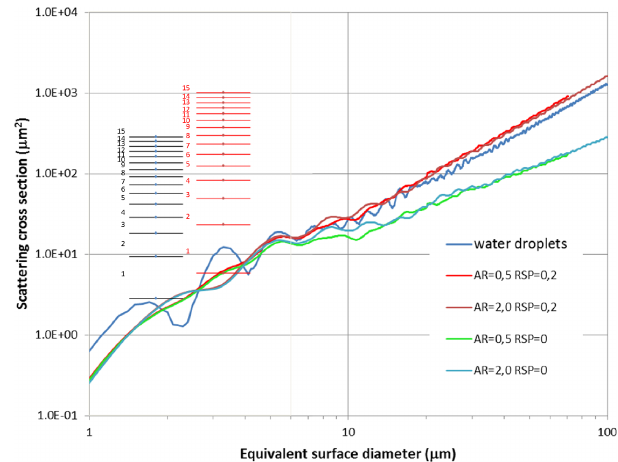
Fig. 7. The scattering cross sections for the FSSP-100 according to particle size obtained from hexagonal ice particle (aspect ratio (AR) of 0.5 and 2, roughness scale parameter (RSP) of 0 and 0.2 ). Calculations were done by averaging out over all orientations. The Mie theory calculations for water droplets are also reported. Both curves are for HeNe laser light ( λ = 632.8nm) and the FSSP-100 scattering geometry (3 ◦ –12 ◦ ). The thin scales represent scattering cross sections for the 15 size classes of standard FSSP (black) and an extended range version (red). Values used to define the bin limit sizes (see Table